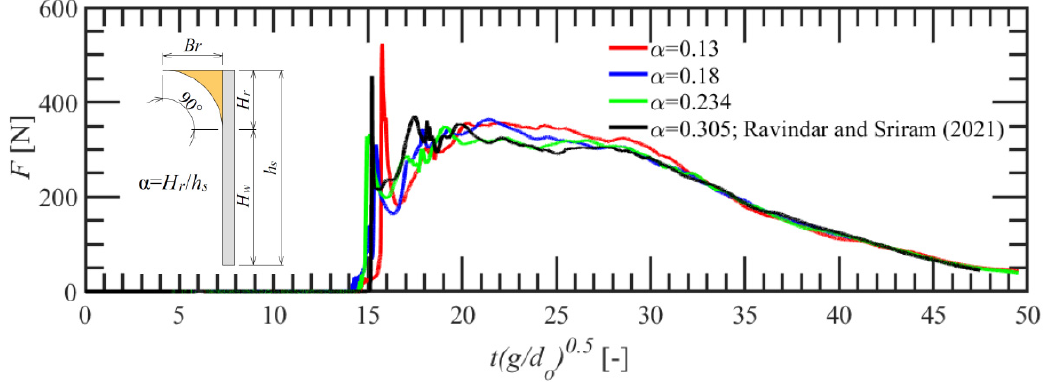
Figure A2. Effect of recurve size ( α ) on the forces acting on the leeward structure.